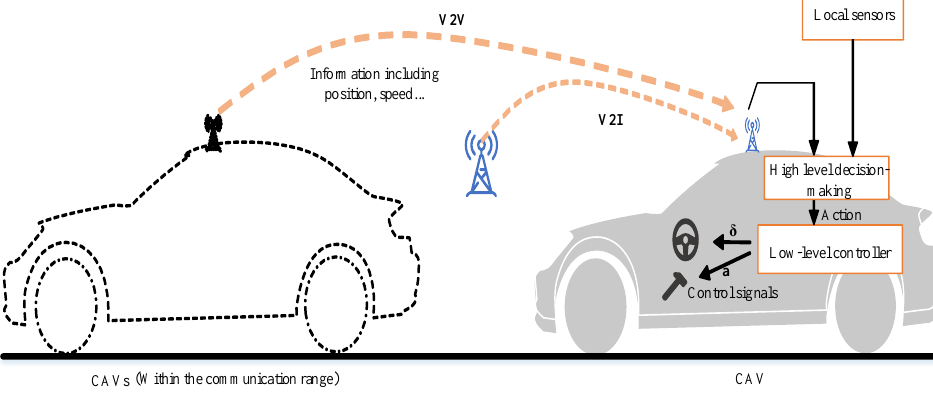
Figure 2. Schematic diagram of the decision control for multiple intelligent vehicles.